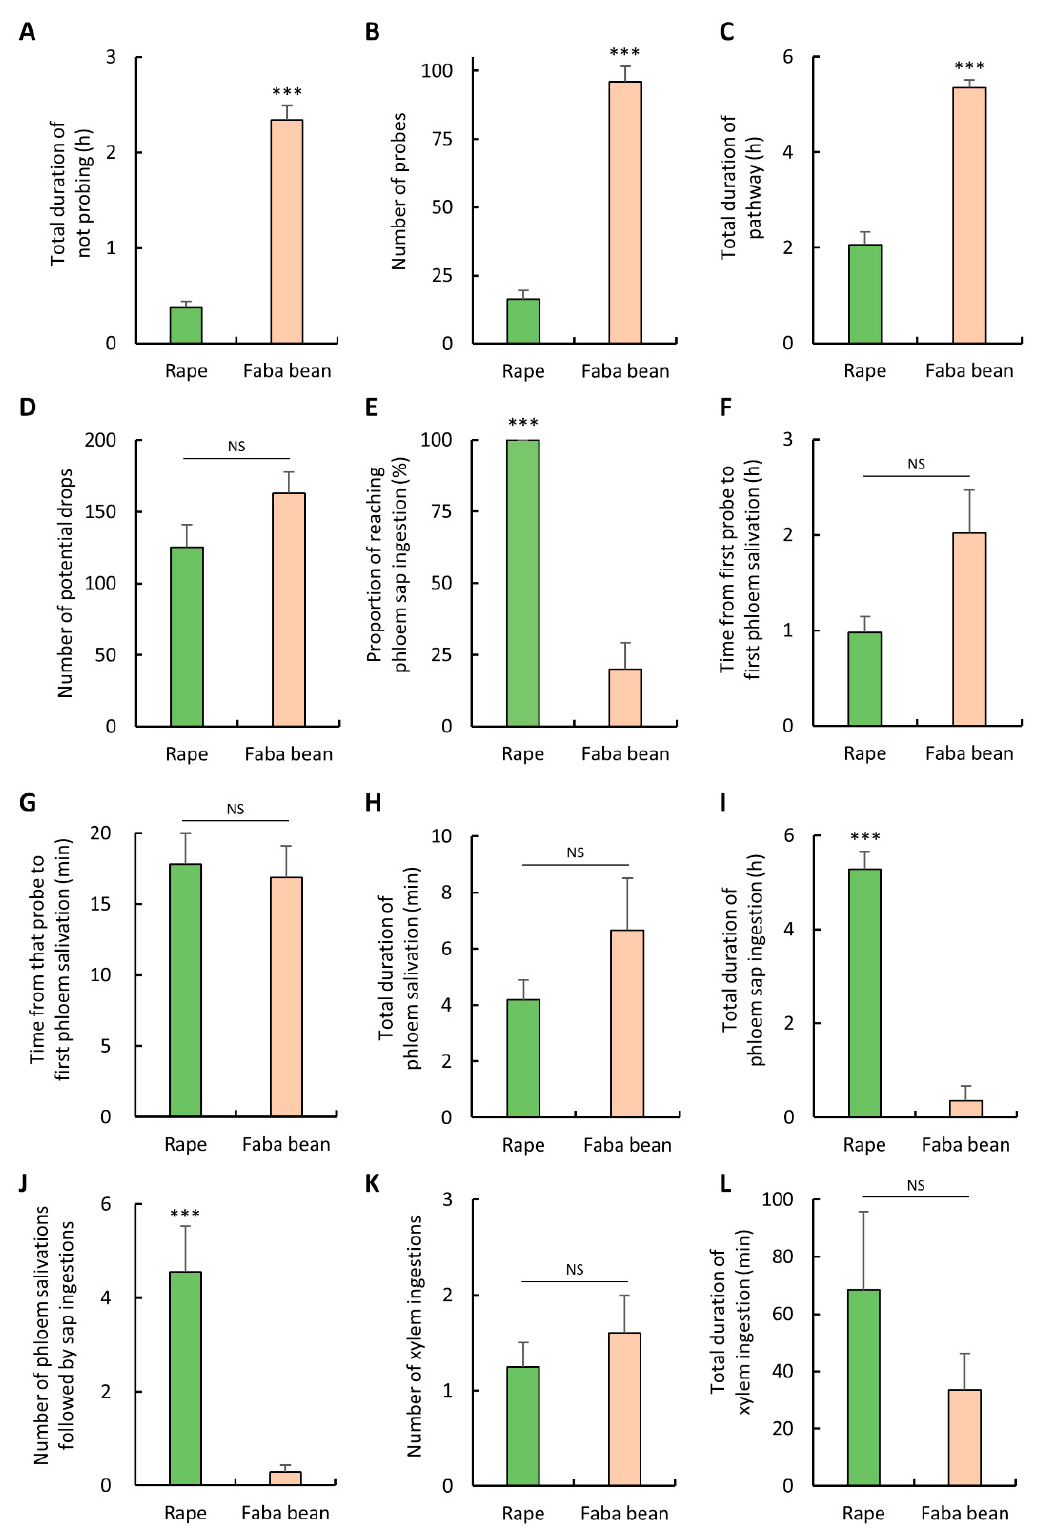
Figure 2. Waveform events and waveform duration of the ( A – D ) non-phloem parameters, ( E – J ) phloem-related parameters, and ( K , L ) xylem-related parameters of M. persicae on rape and faba bean. Error bars represent the standard errors of the means. Asterisks indicate significant differences between aphids probing on rape and faba bean (*** p < 0.001). NS indicates non ‐ significant difference ( p > 0.05).